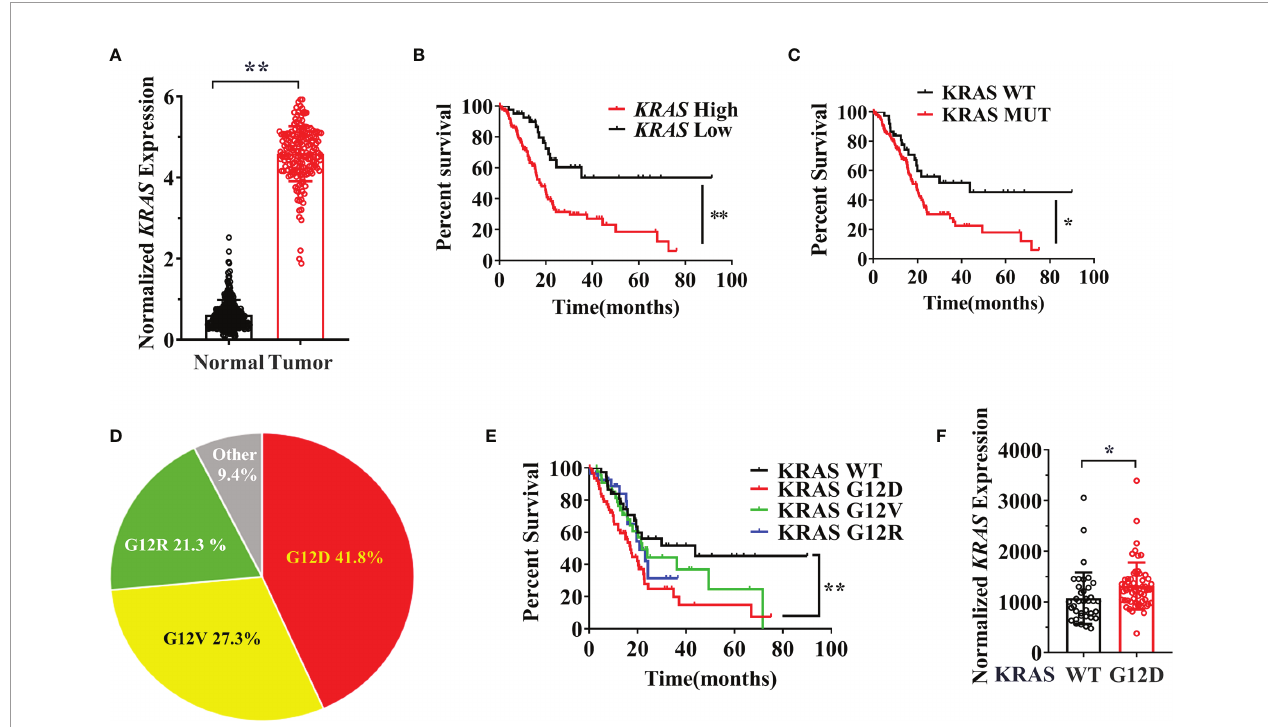
FIGURE 1 | (A) The expression data are fi rst log2(TPM+1) transformed for differential analysis and the log2FC is de fi ned as median (Tumor) and median (TCGA normal + GTEx normal), data were collected and analyzed from GEPIA. (B) The overall survival of the KRAS expression. Data from KM plot, signi fi cance vs cutoff values between lower and upper quartiles of expression. (C) Survival analysis of the pancreatic cancer patients between the KRAS wildtype and KRAS mutation. (D) The proportion of different mutation types in pancreatic cancer. (E) Survival analysis of the pancreatic cancer patients among different KRAS mutation and wild type. (F) KRAS expression level in G12D mutation and wild type group. These data were from the cBioPortal database and http:// fi rebrowse.org/. Data are representative of three independent experiments. T-tests or log-rank Test for the measurements between the two groups; *P < 0.05, **P <